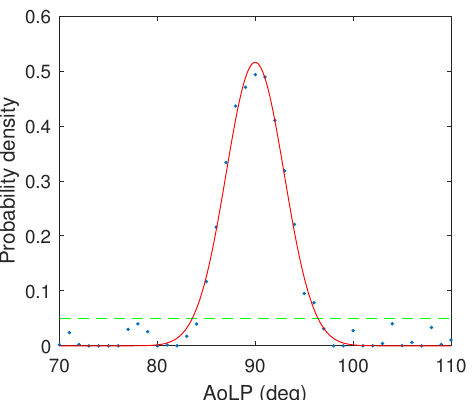
Figure 7. Example of fitting a Gaussian curve to histogram data. Points below the broken line (0.1 × peak value) are not considered in the best-fit algorithm. Data in this graph comprise randomly generated points for the sake of a clear